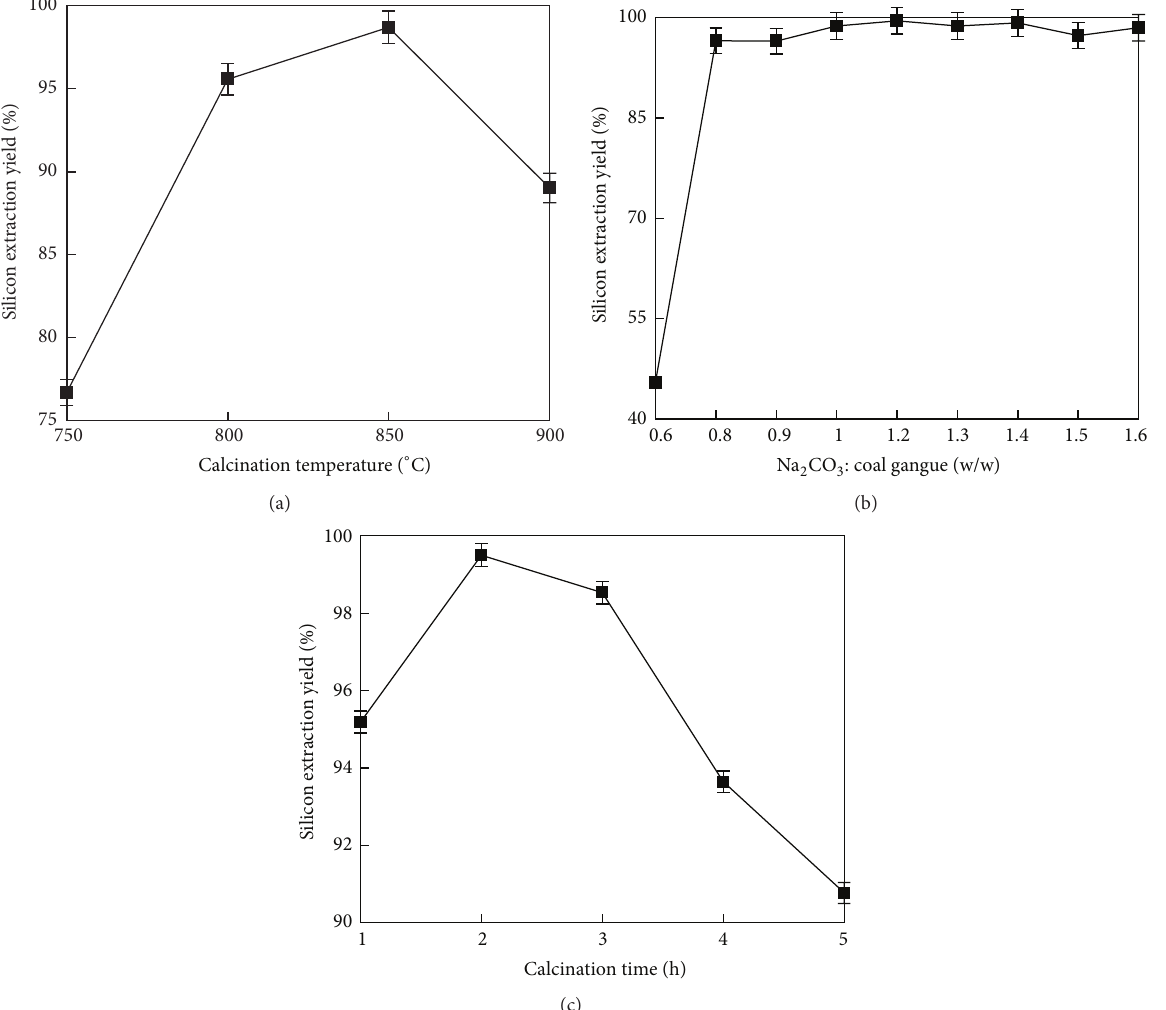
Figure 5: The silicon extraction yields adjusted by (a) the calcination temperature, (b) the Na 2 CO 3 to coal gangue ratio, and (c) calcination time.